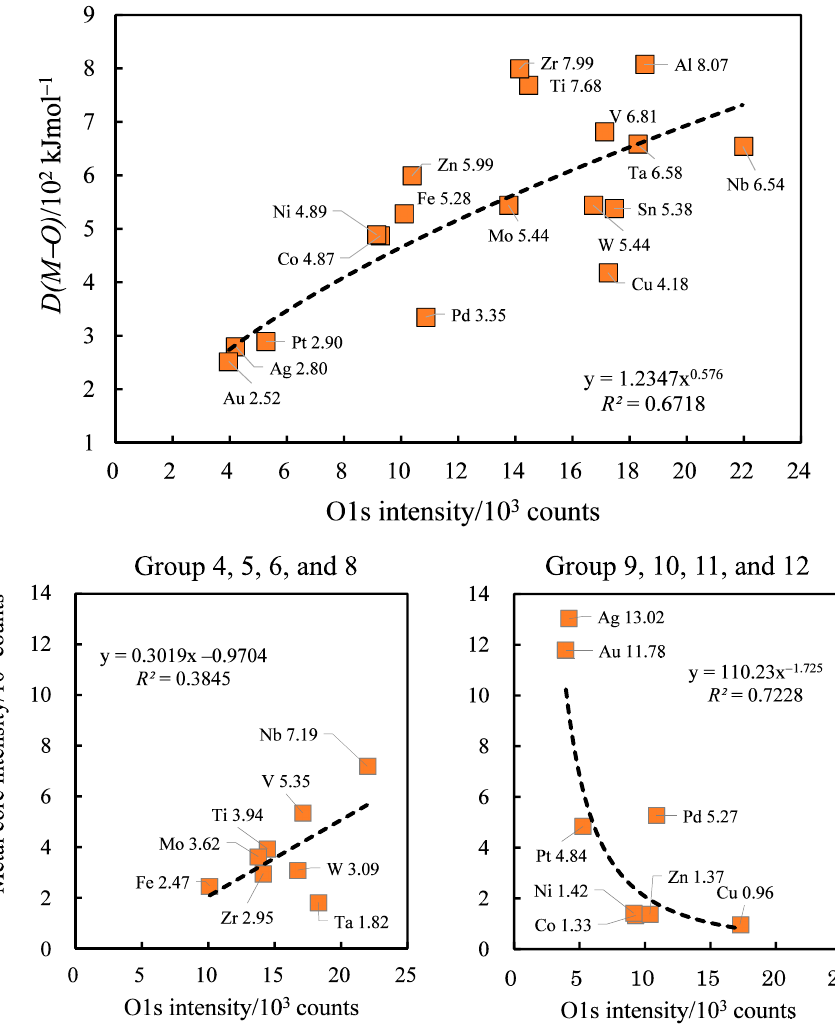
Figure 18. The plots of D(M–O) values for all metals used (above) and XPS intensities of metal core (below) for metals in groups 4, 5, 6, and 8 and in groups 9, 10, 11, and 12 against O1s intensities before TriboEE measurement.